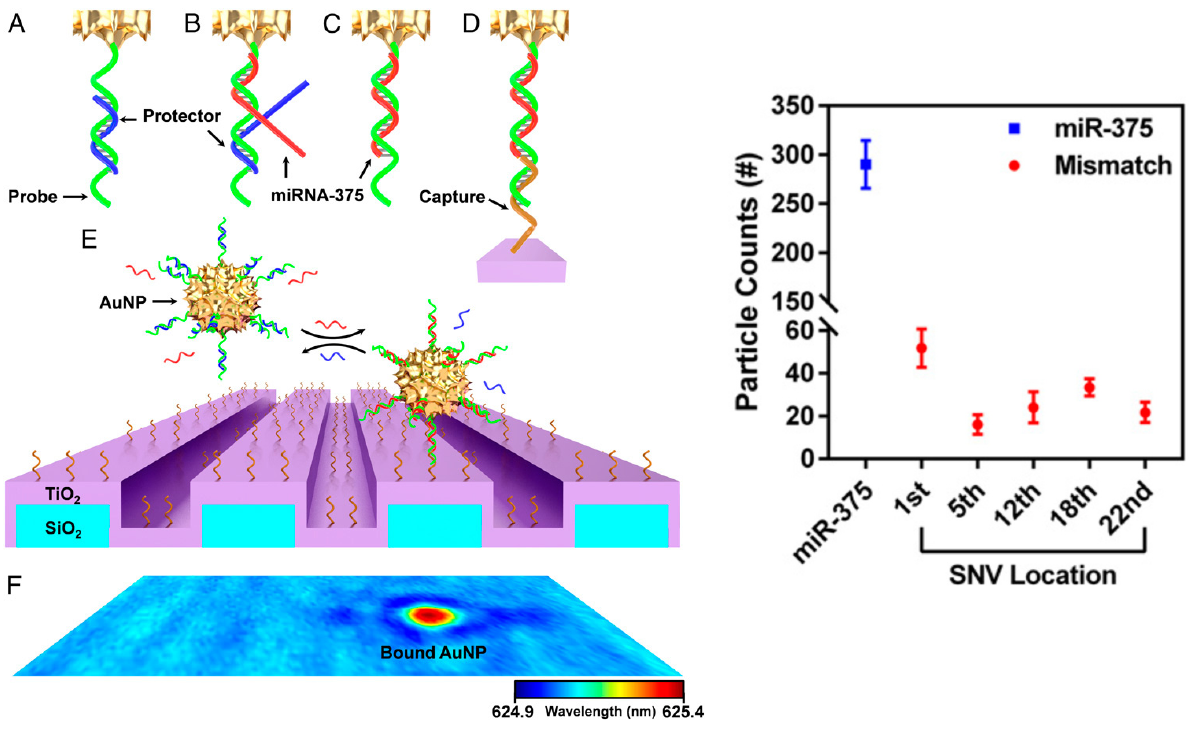
Figure 12. Schemes follow another format. If there are multiple panels, they should be listed as: ( A ) Components of the toehold DNA–AuNP and miR detection by PC biosensors. DNA hybridization probes are conjugated to 100-nm diameter AuNPs. ( A ) The gold-conjugated DNA probe (green) is bound by a partially complementary protector (blue) preventing binding to the PC sensor (purple/blue structure). ( B – D ) miR (red) binds at the probe toehold ( B ), resulting in strand displacement of the protector and exposing additional probe sequence ( C ), which ( D ) stabilizes probe binding to the PC capture DNA on the biosensor surface ( D ). The free energy of the activation reaction can be tuned by the protector (blue) stoichiometry, thus enhancing mismatch selectivity. Bound particles ( E ) can be measured by a shift in the PC resonance wavelength ( F ). All images are not to scale. The PRAM assay images the number of surface-captured particles over time (after miR addition); ( G ) AuNP count quantification of miR-375 and the SNV cases. Adapted with permission from Canady et al. [61] Copyright © 2019 PNAS.